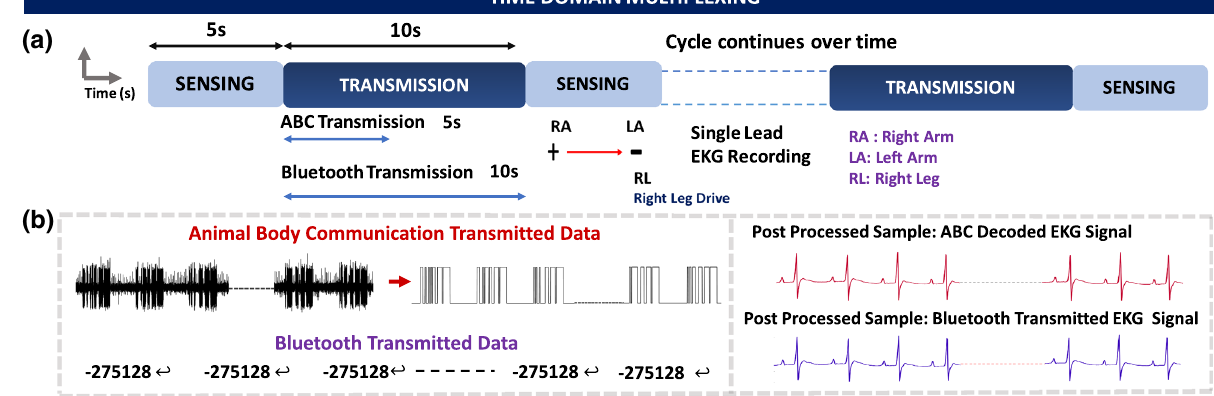
Figure 5. Time multiplexed sensing and transmission cycles: ( a ) Sensing cycles consists of acquiring the single- lead EKG signal using three electrodes, Right Arm, Left Arm and Right Leg. ABC Transmission starts at the end of the sensing cycle and has the same duration as the sensing cycle. Bluetooth transmission duration is almost twice the ABC transmission duration. Upon the completion of both transmissions, the sensing cycle restarts, and this cycle repeats. ( b ) Post-processing steps on ABC transmitted sequence and Bluetooth transmitted sequence